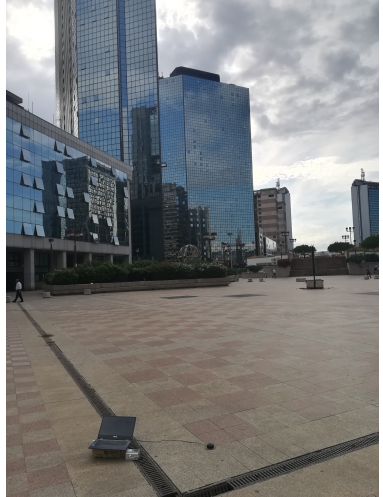
Figure 3. CDN site.